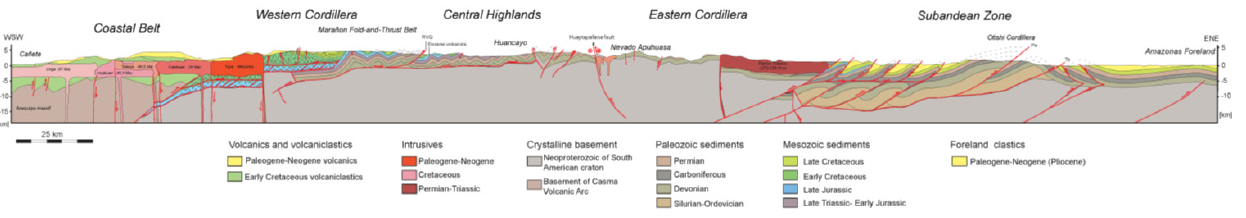
Figure 14. Southern Traverse: This balanced cross-section runs from the Pacific coast (Cañete) to Huancayo, the Otishi Cordillera and into the Amazonas Foreland. The trace